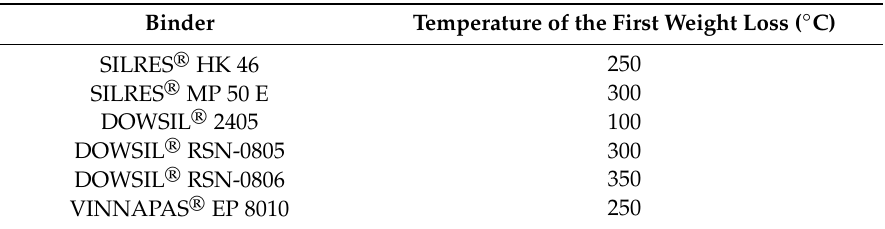
Table 1. Temperature of the first weight loss observed for the polymerized commercial binders by